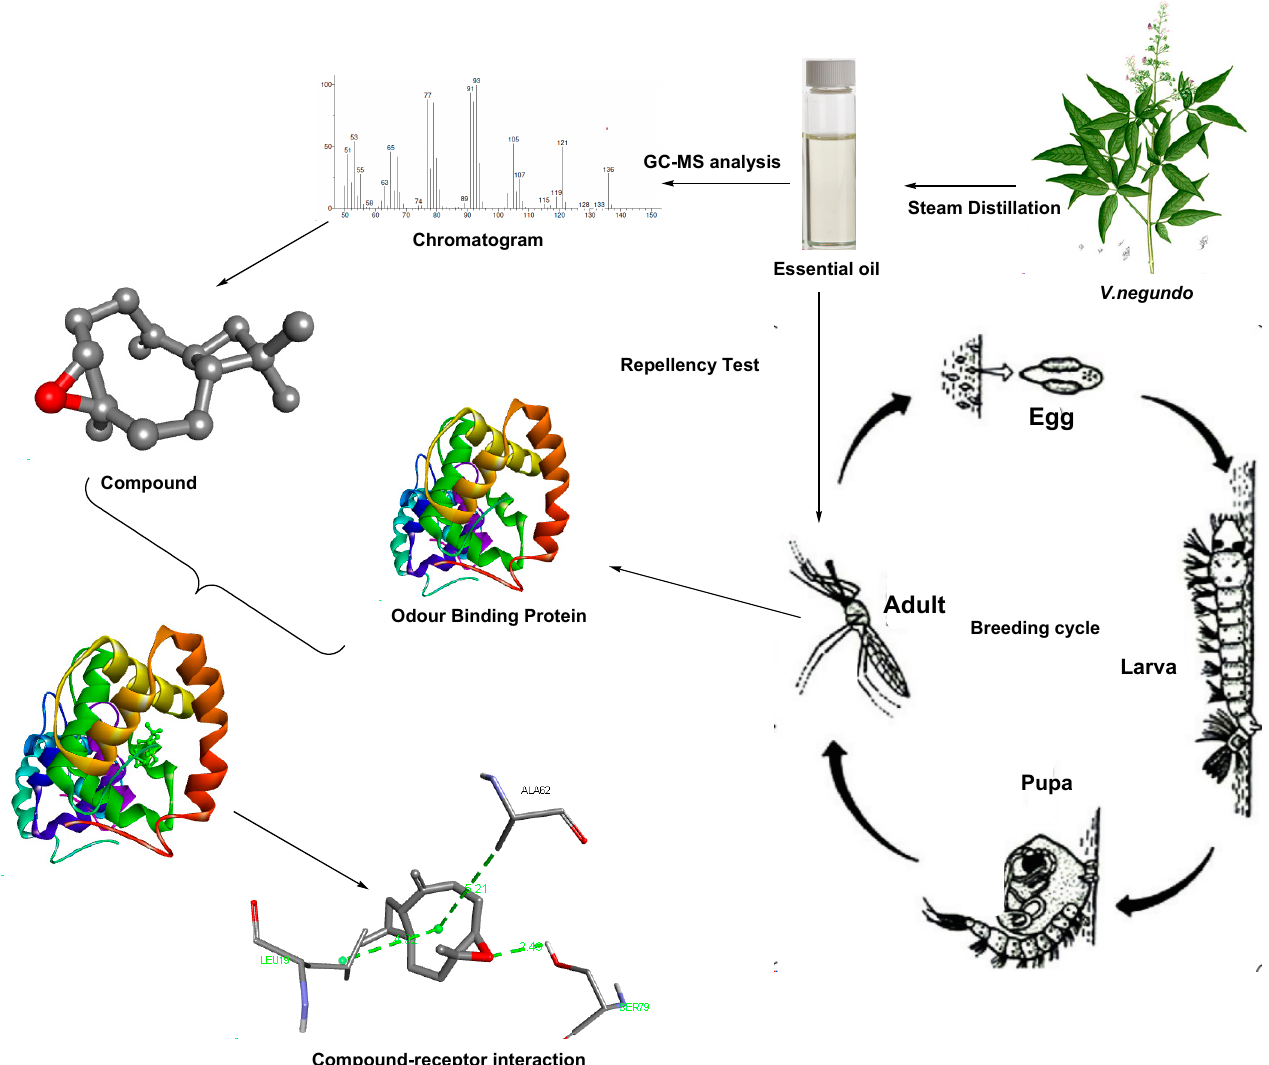
Figure 2. Graphical illustration of repellency and odorant binding protein efficiency using a molecular docking-based technique.